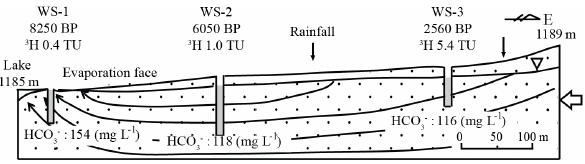
Figure 8. The flow model of groundwater near the Sumu Jaran Lake. The HCO − concentrations of each wells are shown in the 3